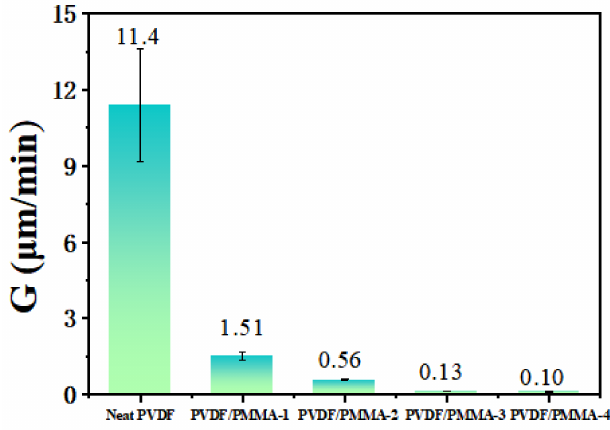
Figure 3. The growth rate of PVDF sphere diameter in neat PVDF and PVDF/PMMA blends crystallized isothermally at 150 ◦ C with various molecular weights of